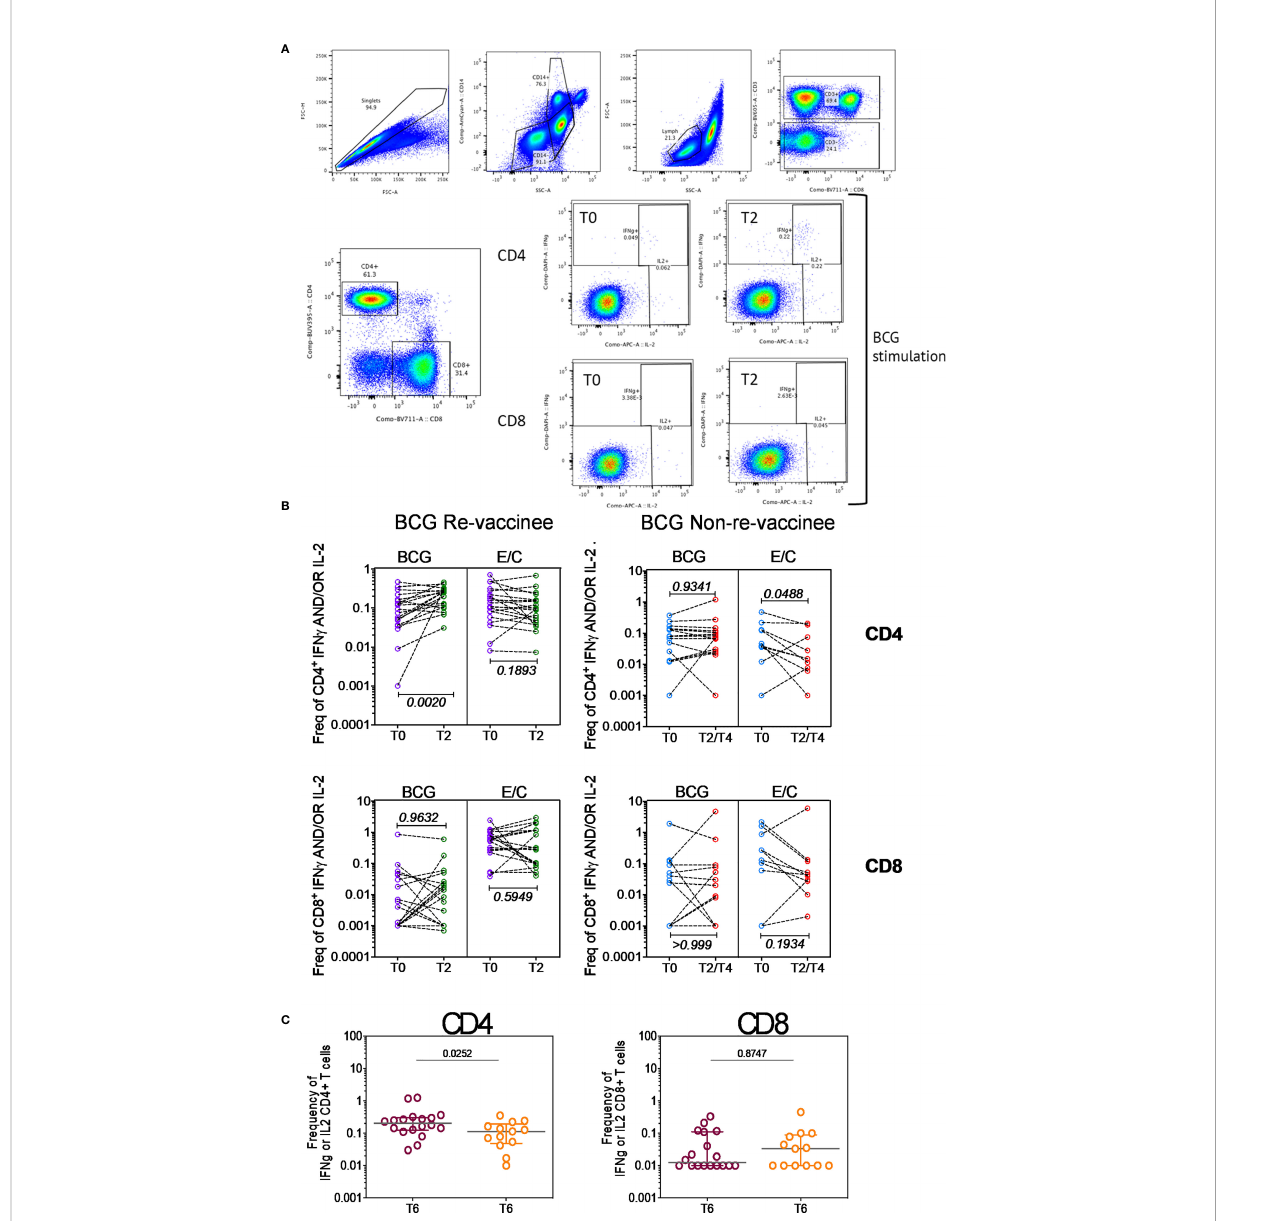
FIGURE 4 BCG revaccination boosts T cell responses to Mtb antigens at 8-10 weeks post vaccination prior to COVIDSHIELD ™ vaccination. (A) A representative gating strategy for obtaining CD4+ and CD8+ T cells is shown. Also shown are representative plots for IFN- g and IL-2 expression post BCG stimulation at T0 and T2 in a BCG re-vaccinee in CD4+ and CD8+ T cells. (B) Mtb -speci fi c T cell responses after BCG revaccination. Whole blood from 20 BCG-RV and 9 BCG-NRV at baseline (T0) and 10-12 weeks (T2) post-revaccination was stimulated or not with either BCG or ESAT6/CFP10 with for 12 hrs after which samples were subjected to RBC lysis, fi xed, frozen and archived. Frozen samples were thawed, washed and stained with a 17-color antibody panel to assess expression of adaptive effectors IFN- g and IL-2 in the CD4+ and CD8+ T cells. Frequencies of IFN- g or IL-2 CD4+ and CD8+ T cells after background subtraction were plotted for comparison of responses at T0 and T2. The upper panel shows data for CD4+ T cells (BCG-RV on the left and BCG-NRV on the right) and lower panel shows data for CD8+ T cells (BCG- RV on the left and BCG-NRV on the right). Wilcoxon signed-rank t-test was used for determining statistical signi fi cance. (C) PBMCs collected from COVISHIELD ™ vaccinated BCG-RV (purple circles) and BCG-NRV (orange circles) were stimulated with BCG for 20hr. CD4+ and CD8+ T cells were analyzed for intracellular expression of IFN- g or IL-2. Grouped scatter plot comparing the frequencies of IFN- g or IL-2 in CD4+ and CD8+ T cells in samples from COVISHIELD ™ vaccinated BCG-RV and BCG-NRV (orange circles) collected at 78-94 weeks post BCG re- vaccination and 20-23 weeks post COVISHIELD ™